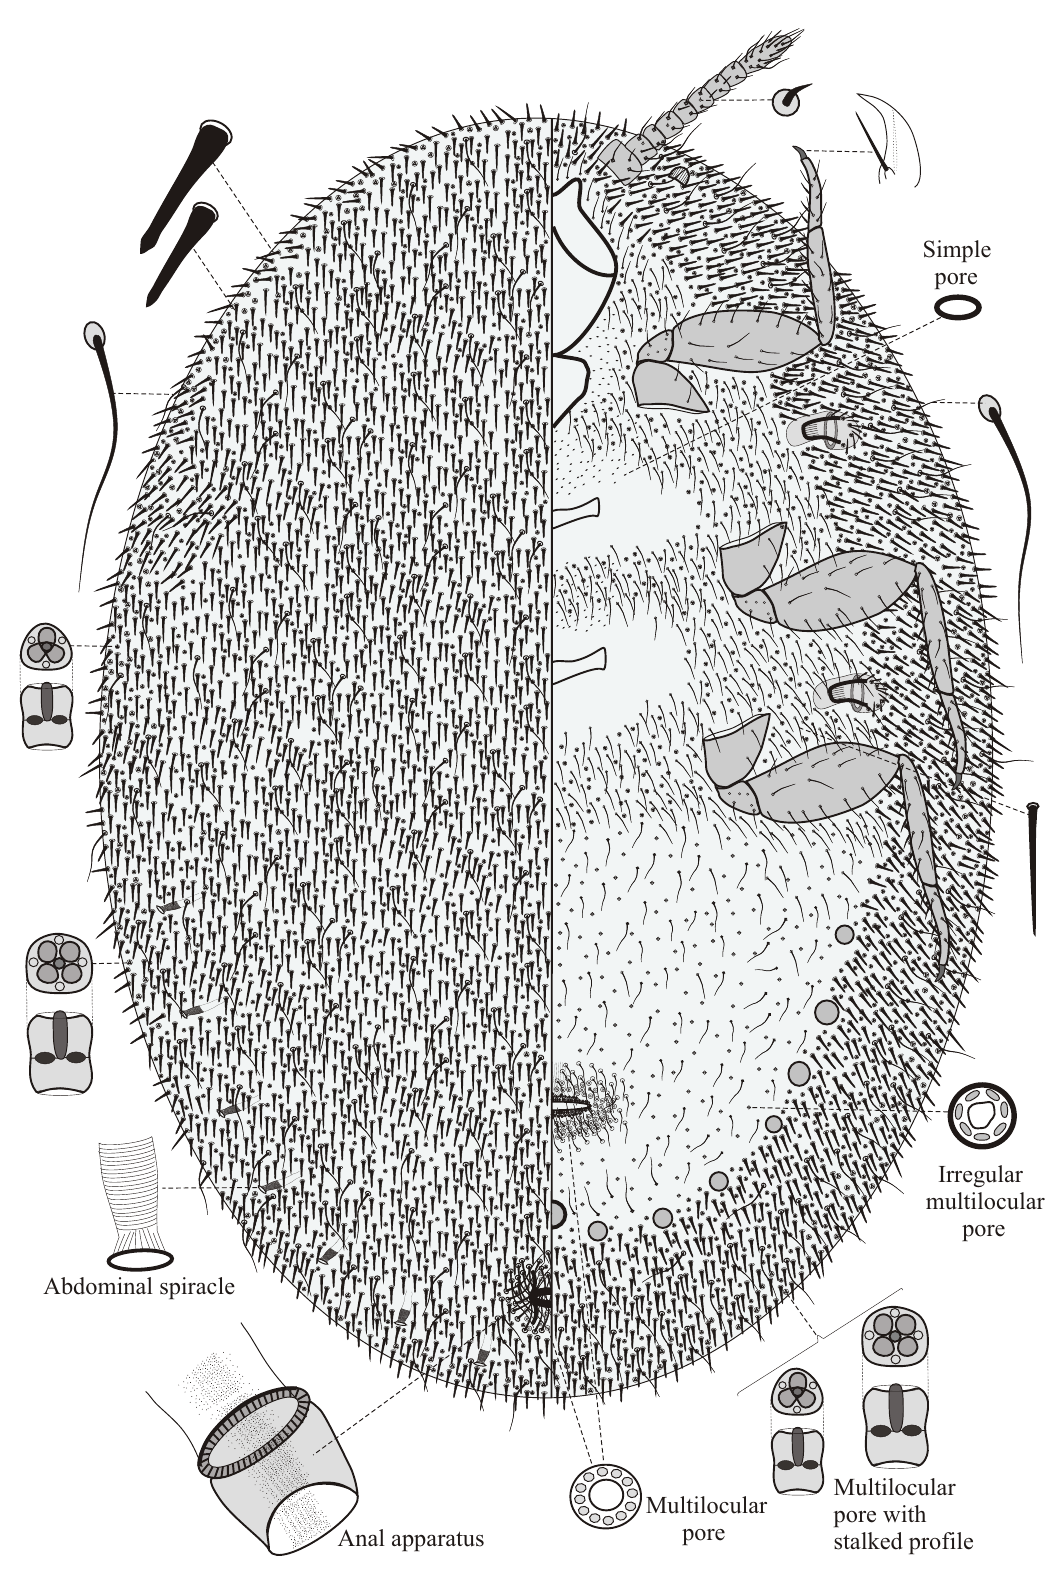
Fig. 2. Gompholopium quercicola gen et sp. nov., holotype, adult ♀ (ZIN RAS, K 1548). Morphology. Not to